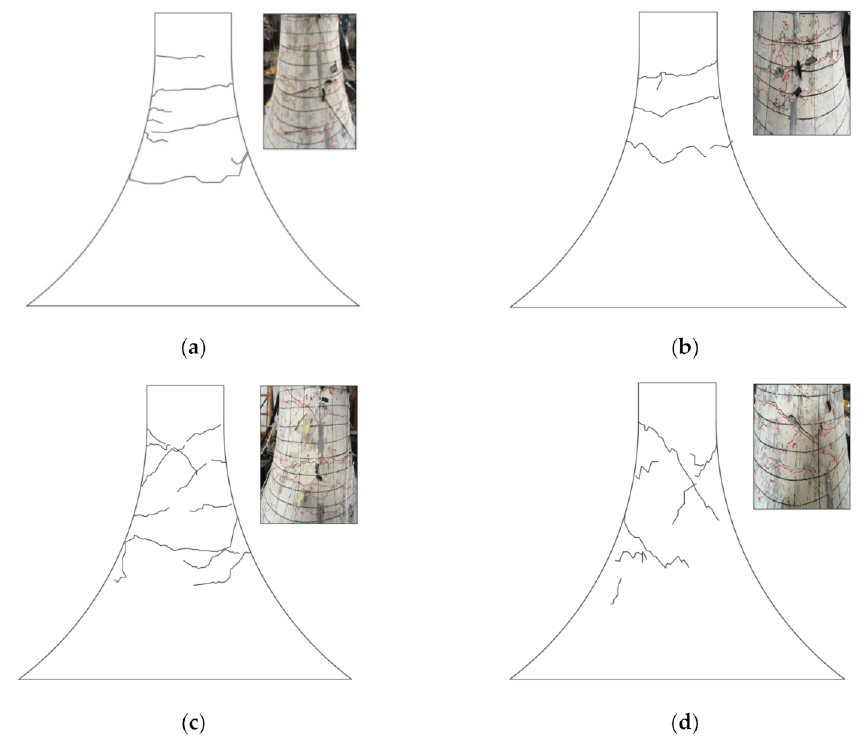
Figure 9. The failure mode of GD2 specimen: ( a ) East (forward), ( b ) West (reverse), ( c ) South (left side), and ( d ) North (right